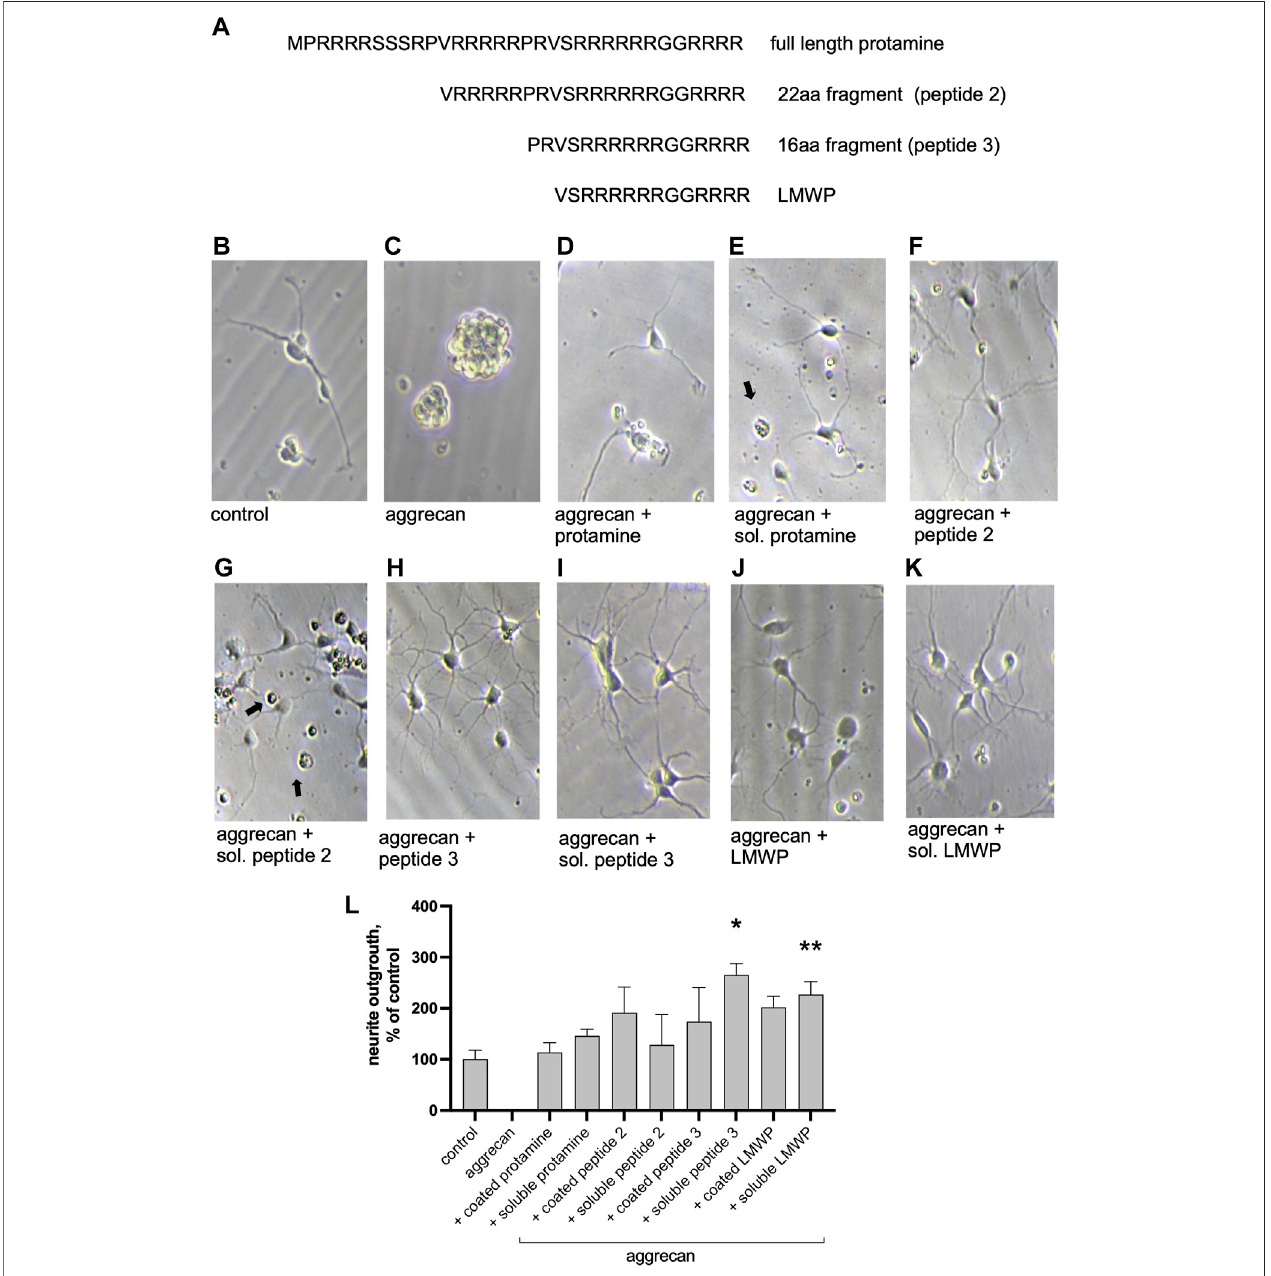
FIGURE 2 | Protamine and its fragments enhance neurite outgrowth on the aggrecan-coated substrate. (A) Sequence of the full-length protamine and the tested fragments of 22, 16 and 14 (LMWP) amino acids. (B – K) Morphology of hippocampal neurons cultured for 2 days on aggrecan, or on aggrecan with protamine or its peptides (10 μ g/ml) that were precoated together with aggrecan or added in the culture medium at the time of cell plating (marked soluble “ sol. ” ). Black arrows point to dead cells. (L) Quanti fi cation of the effect of protamine and fragments on neurite outgrowth measured from about 70 neurons/replicate and normalized to control level. * p < 0.05, ** p < 0.01; ANOVA followed by pairwise comparison with Fisher ’ s LSD test versus control group; n = 3.